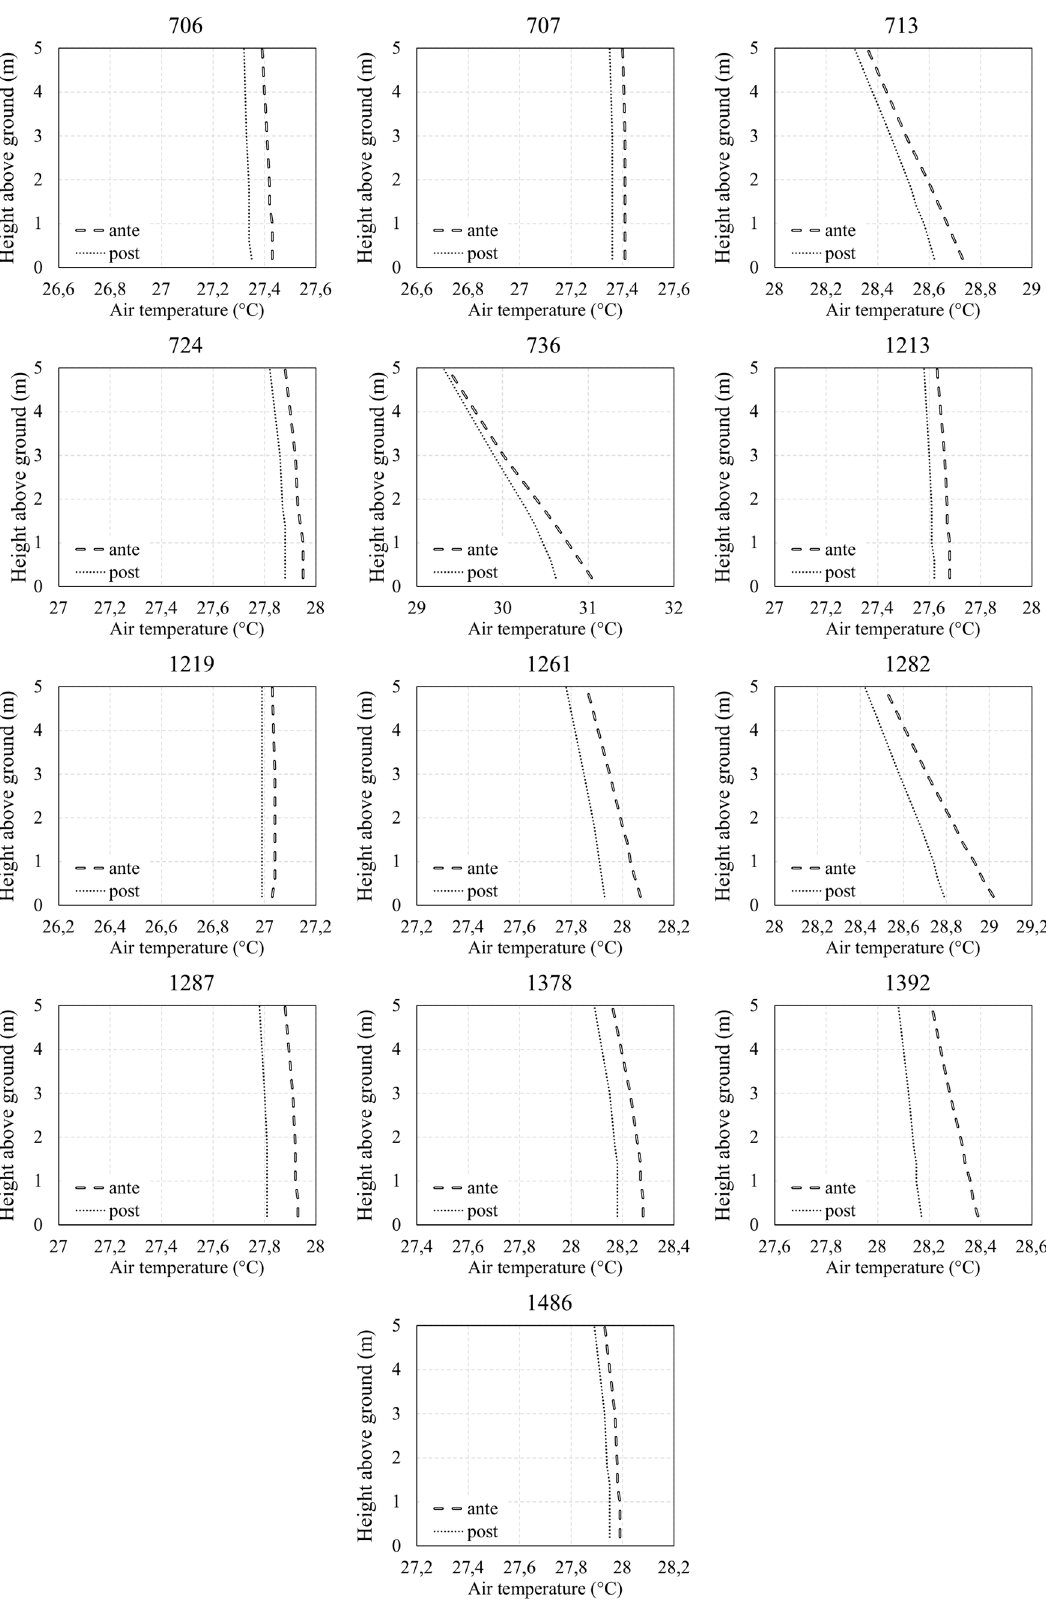
Figure 5. Air temperature variations from ante- to post-operam with cool materials.